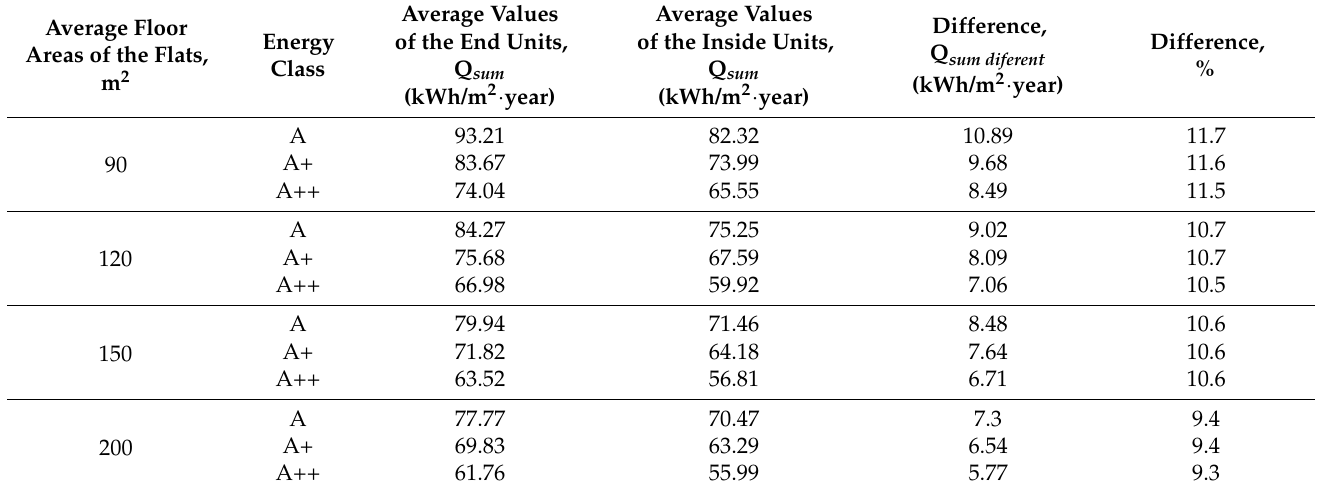
Total heat loss through the building envelopes of the flats with different floor areas and various building energy classes calculated per 1 m 2 of the heated floor area expressed in kWh/m 2 per year depending on the location of the flat in the building plan are presented in Table 4. Table 4. Total heat energy loss kWh per 1 m² of the floor area per year of the flats of various size and energy classes, considering where the flat is situated in the building plan.